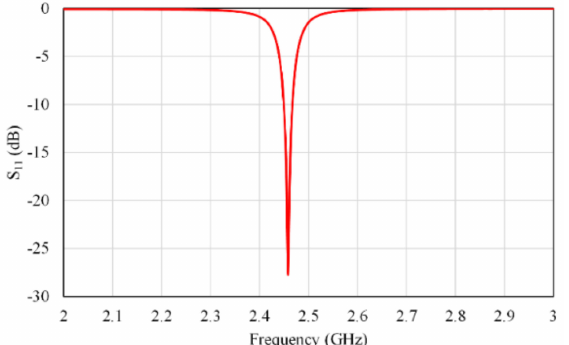
Figure 2. S 11 response of a single antenna element; patch length and width = 28 mm, slot length = 9.3 mm, and slot width = 4.5